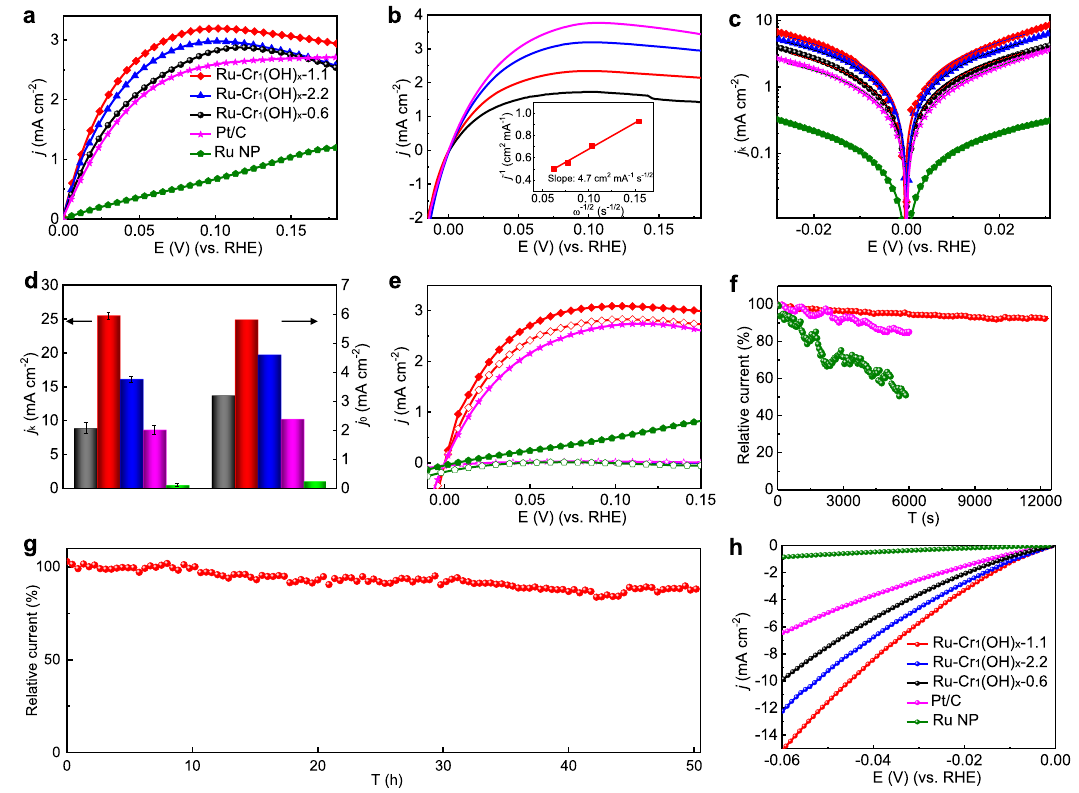
Fig.5|ElectrochemicalHORperformance.a HORpolarizationcurvesofdifferent catalysts. b Polarization curves of Ru – Cr 1 (OH) x − 1.1 at different rotation speeds ( ω ) of 400, 900, 1600, and 2500rpm (from bottom to top). Inset is the Koutecky – Levich plot at an overpotential of 25mV. c Calculated HOR kinetic cur- rent densities ( j k ) vs. potential plots recorded from a . d Comparison of j k and j 0 of Ru – Cr 1 (OH) x − 0.6 (black), Ru – Cr 1 (OH) x − 1.1 (red), Ru – Cr 1 (OH) x − 2.2 (blue), Ru NPs (green),andPt/C(pink).Errorbarsshowasmeans.d. e